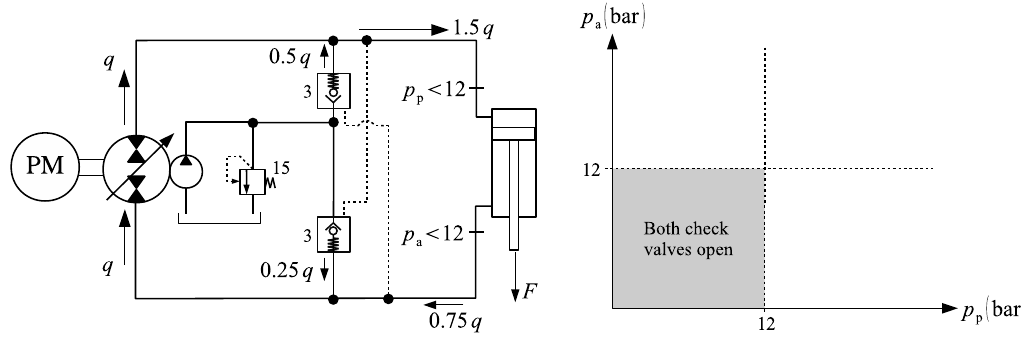
Figure 12. Example of compensation valves misbehaviour.